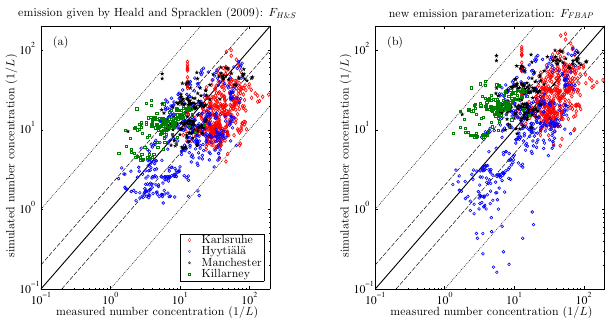
Figure 8. Comparison for all case studies: Measured FBAP num- ber concentrations plotted vs. simulated number concentrations of (a) fungal spores based on the Heald and Spracklen (2009) emis- sion flux and (b) FBAP based on the new emission parameterization derived from a multiple linear regression to FBAP concentrations. Solid black lines represent the 1:1 line, dashed lines the 1:2 line and dotted lines the 1:10 line.